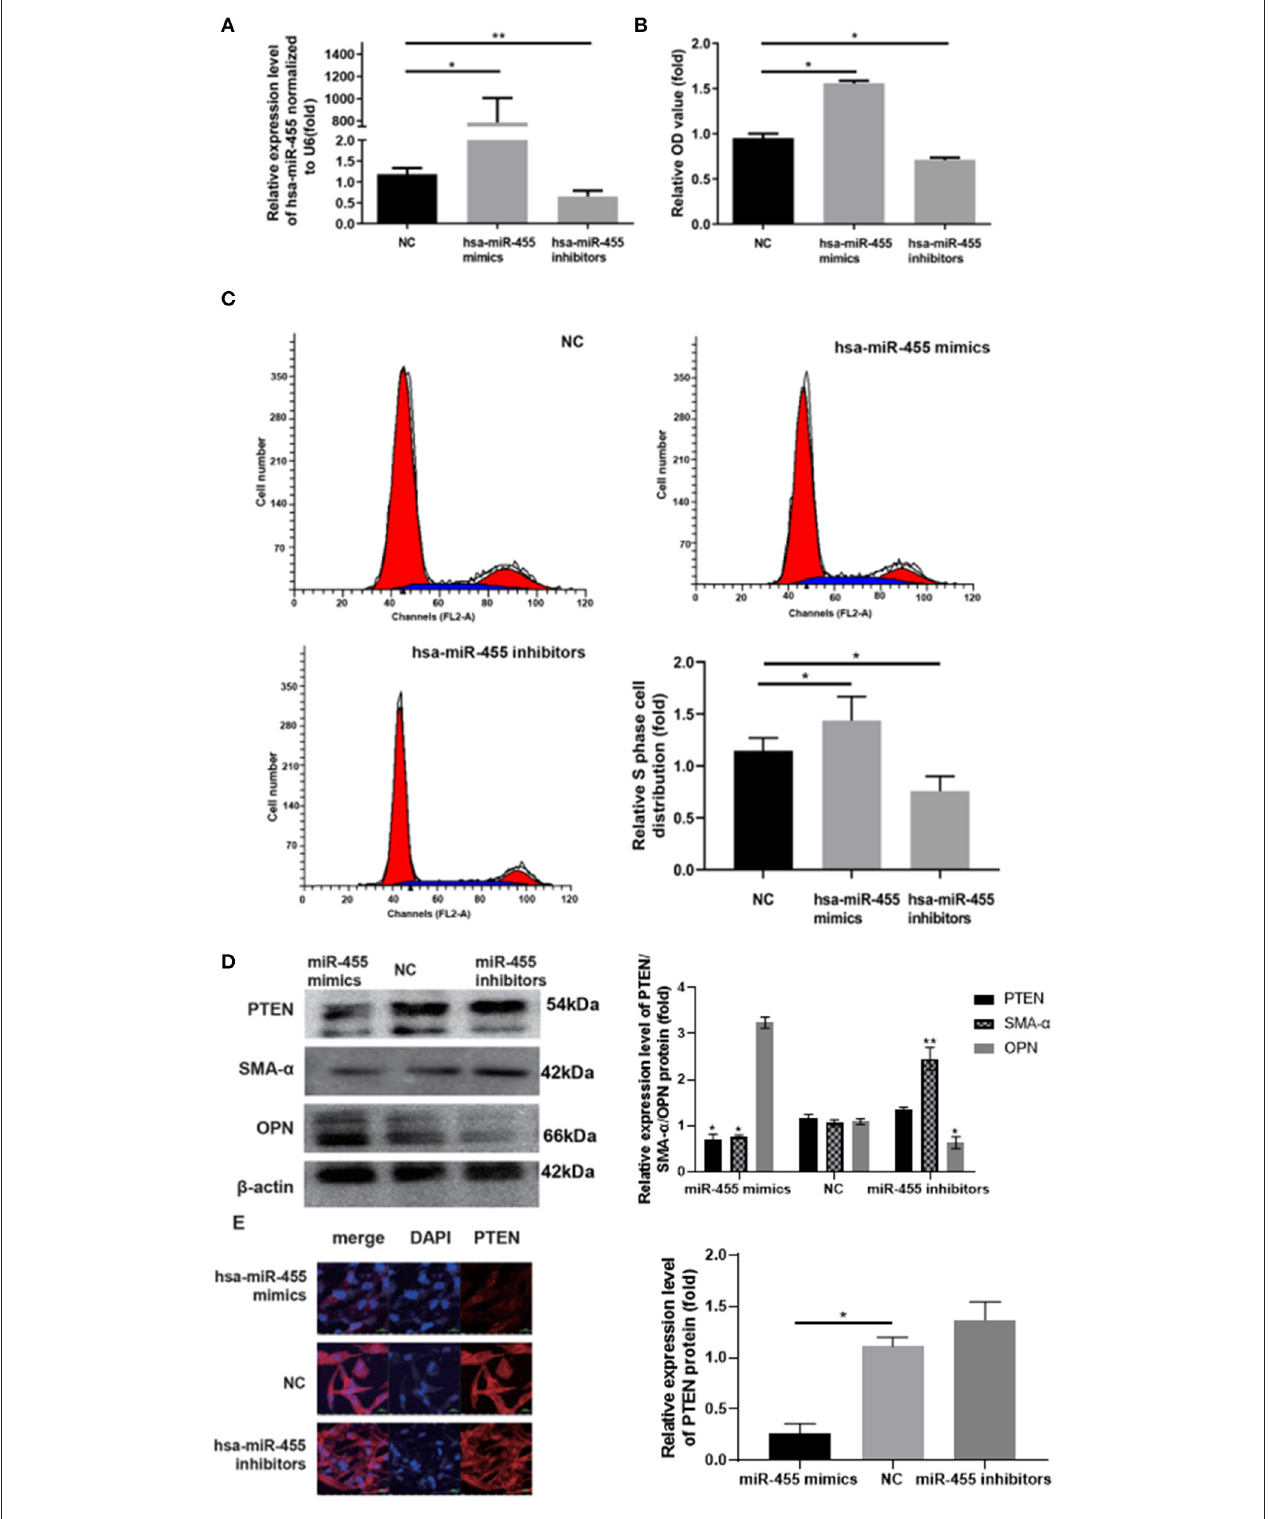
FIGURE 2 | (A) Expression levels of hsa-miR-455 in T/G HA-VSMCs transfected with hsa-miR-455 mimics, inhibitors, or NC examined by qRT-PCR. Hsa-miR-455 was normalized to U6. (B) Proliferation of T/G HA-VSMCs after transfecting hsa-miR-455 mimics, inhibitors, or NC measured by CCK-8 assay. (C)